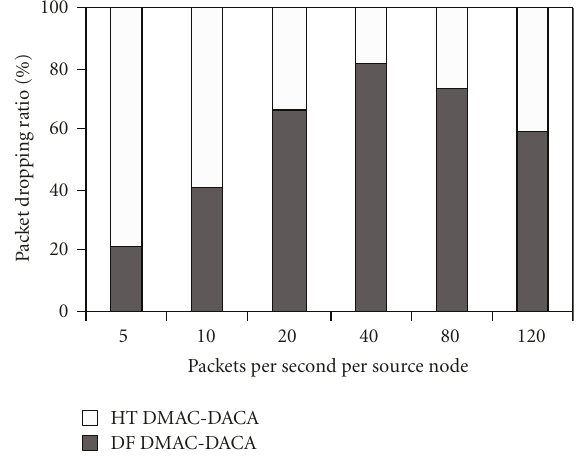
Figure 21: DMAC-DACA: deafness versus hidden terminals.